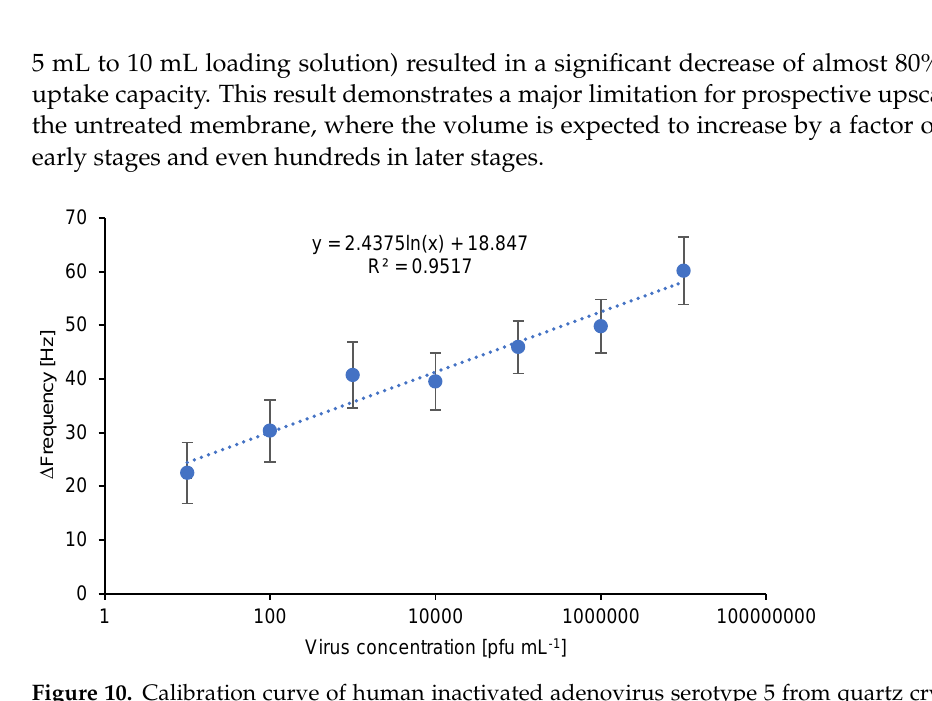
Figure 10. Calibration curve of human inactivated adenovirus serotype 5 from quartz crystal micro- balance (QCM) measurements. Limit of detection (LOD): 10 pfu mL −1 . Table 5. Membrane filtration calculations for PES